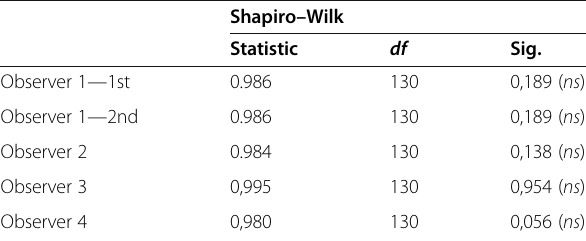
Table 4 Tests of normality — distribution of differences between examiners